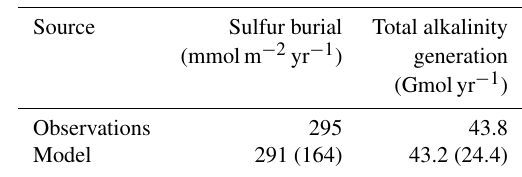
Table 2. Estimated S burial (mmolm − 2 yr − 1 ) and associated TA generation (Gmolyr − 1 ) for site F80 (lat 58.0000, long 19.8968) be- tween 1970 and 2009. Both S contents and dating were taken from Lenz et al. (2015b). The basin-scale calculation was based on the total muddy sediment area for the Baltic Proper in BALTSEM of 74300km 2 (Table 1). Numbers in parentheses represent S burial due to in situ S formation only, thus excluding S burial due to FeS